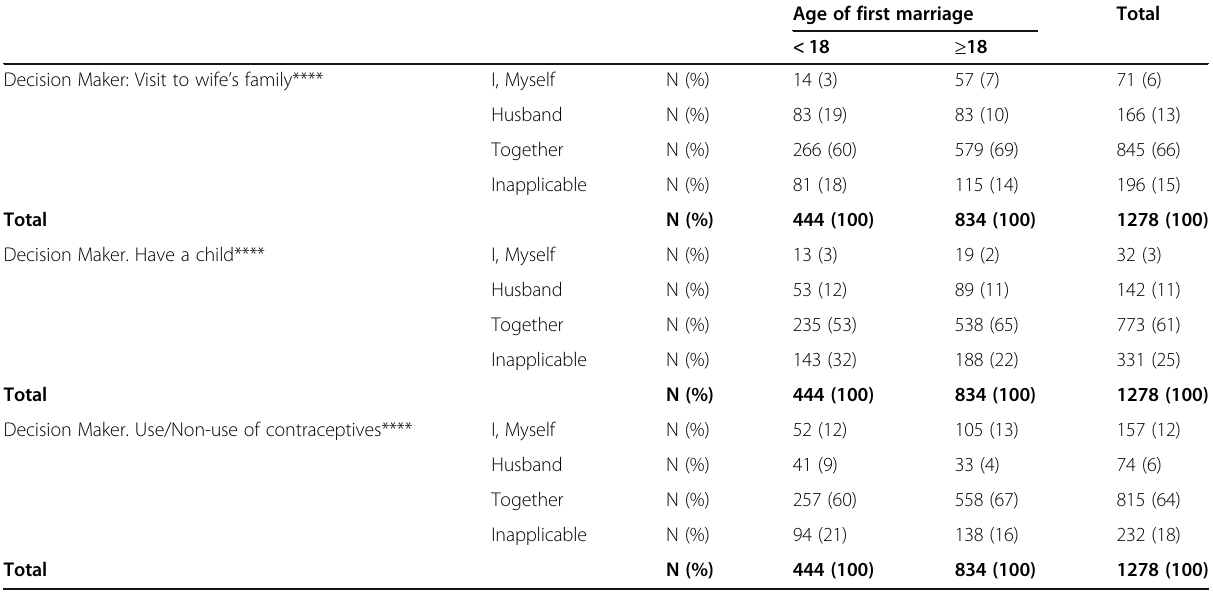
Age of first marriage